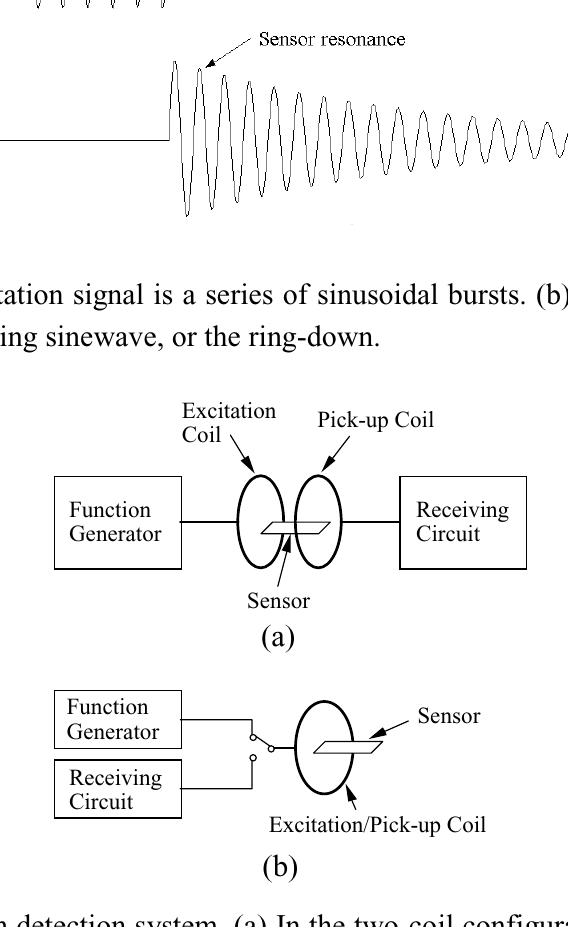
Figure 5. Time domain detection system. (a) In the two-coil configuration, the excitation coil is used to generate the excitation pulse and the pick-up coil receives the sensor response. (b) Only one coil is needed for excitation and reception if an electronic switch is used to isolate the excitation circuit and receiving